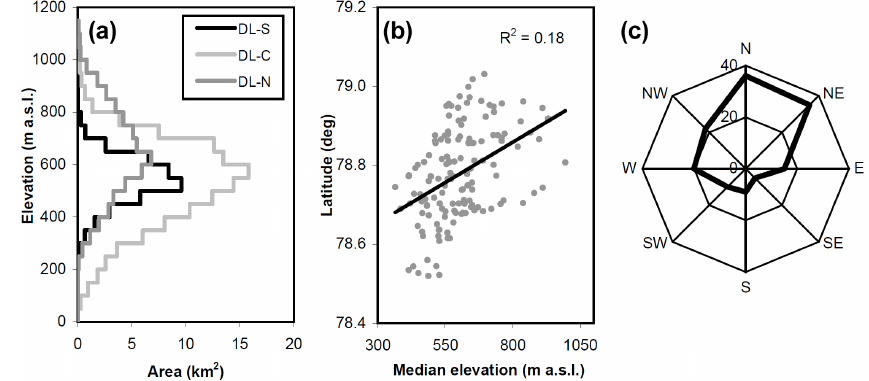
Figure 3. Main features of the modern glacier geometry in DL: area-altitude distribution (a) , scatter plot of latitude against median glacier elevations (b) , and frequency distribution of mean glacier aspects (c)